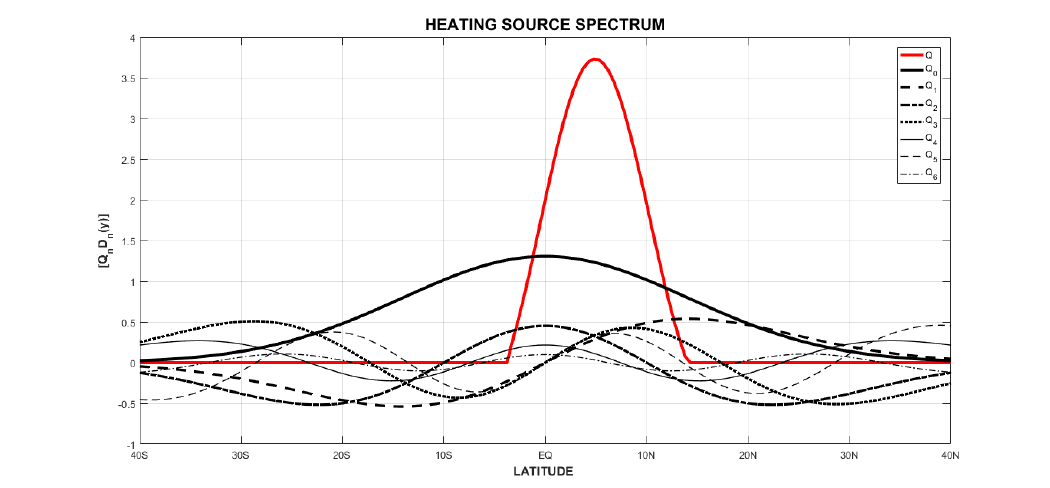
Figure 4. Spectrum of the diabatic heating source located at 5 ◦ N ( red ) and its meridional components ( black ).